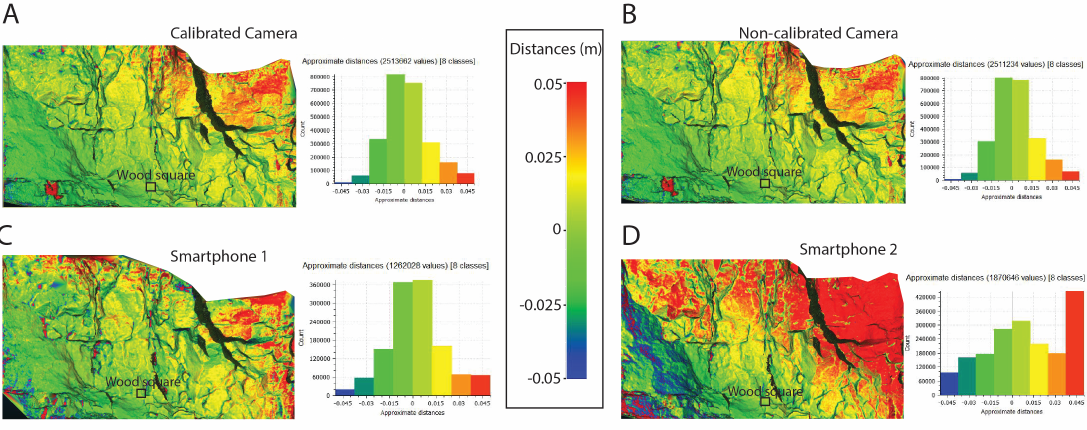
Figure 7. Comparison between LS and DP with calibrated camera ( A ), non-calibrated digital camera ( B ), smartphone 1 ( C ) and smartphone 2 ( D ). Models were georeferenced using the five targets 1–5. To improve the readability of the results, we used five slope profiles created through each 3D model, starting from the wooden square. Profile 1 is horizontal, and on the left side of the wooden square. Relative to Profile 1, Profiles 2, 3, 4 and 5 are oriented at 45